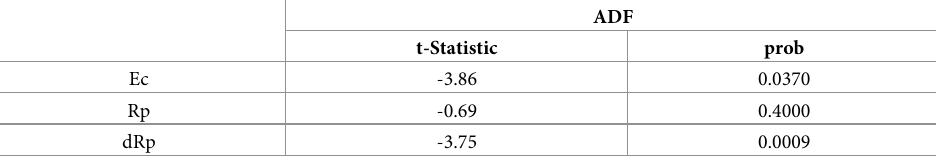
Table 5. Augmented Dickey-Fuller unit root test.